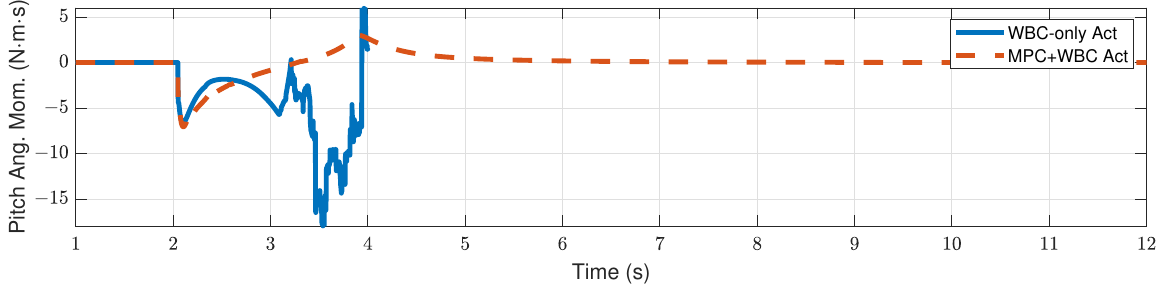
Figure 10. Centroidal pitch angular momentum of the robot under the frontal impact of an 11 kg rigid ball.